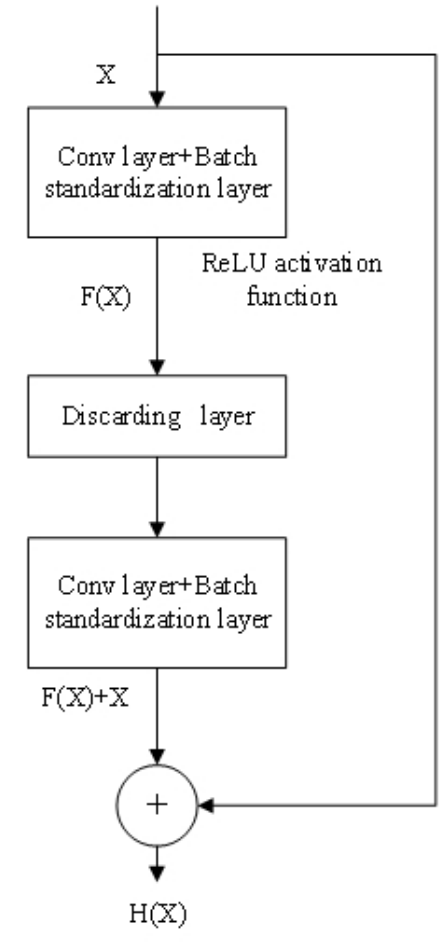
Fig. 3. Structure diagram of improved residual